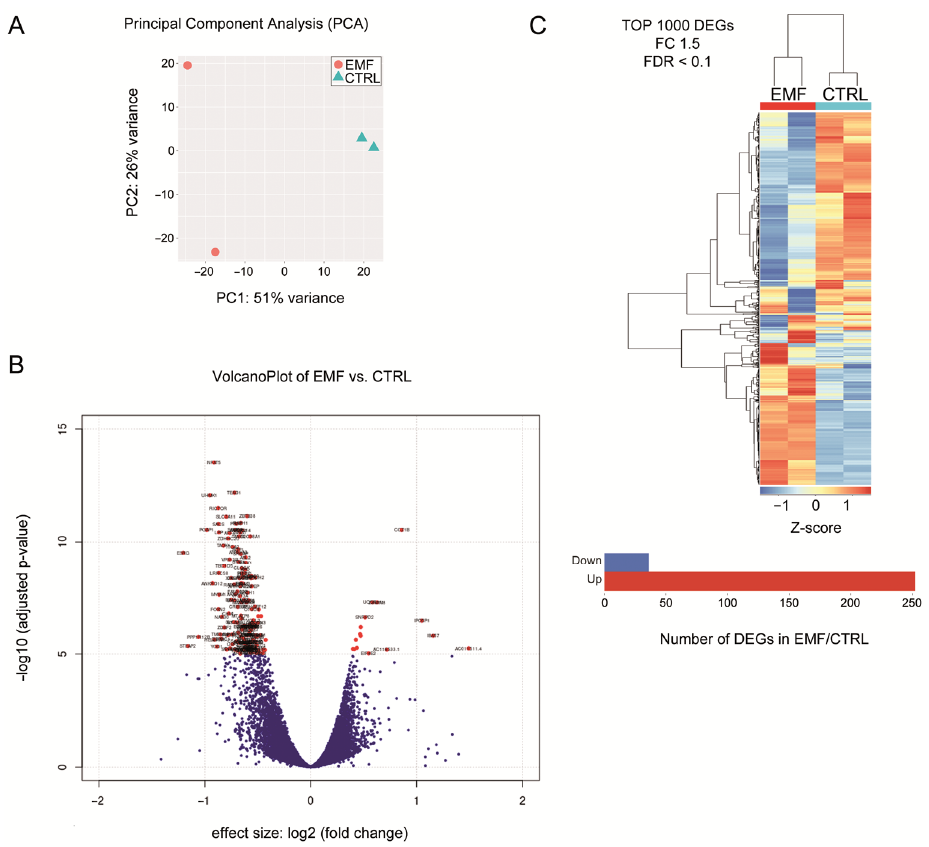
Figure 4. Identification of DEG in HEI-193 cells following chronic EMF. ( A ) Principal component analysis (PCA) indicated that PC#1 included 51% of system variability and this tends to separate the sample replicates of EMF condition. Indeed, PC#2 included 26% of system variability. ( B ) Volcano plot displaying DEGs between the control (CTRL) and EMF-exposed cells. The vertical axis (y-axis) corresponds to the mean expression value of log 10 ( q -value), and the horizontal axis (x-axis) displays the log 2 (fold change) value. The red dots represent the upregulated expressed transcripts; the blue dots represent the transcripts whose expression is downregulated. Positive x -values represent upregulation and negative x -values represent downregulation. ( C ) Heat map of the 1000 top upregulated genes in VS cells from CTRL versus EMF exposed. DEGs were selected setting a 1.5 fold change with a p -value of